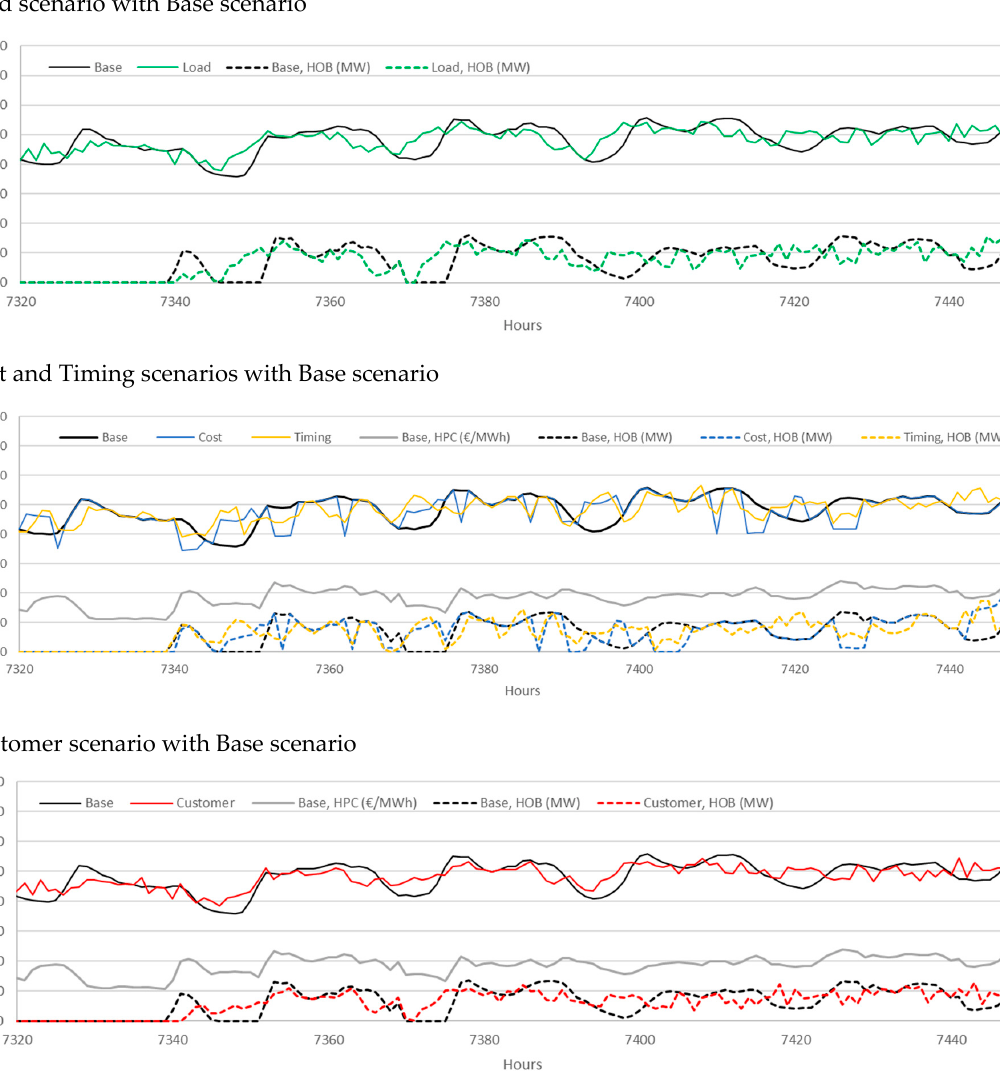
Figure 2. The effect on heat production with heat-only boilers (HOBs) in medium-sized district heating (DH) systems with different demand side management (DSM) scenarios (Load, Cost, and Timing, and Customer). The black line represents the heat load in the Base scenario. The dashed lines represent how the HOB production changes in different scenarios, respectively. The grey line represents the heat production cost of the Base scenario (secondary axis), which is used as a control strategy for the Cost and Timing scenarios.